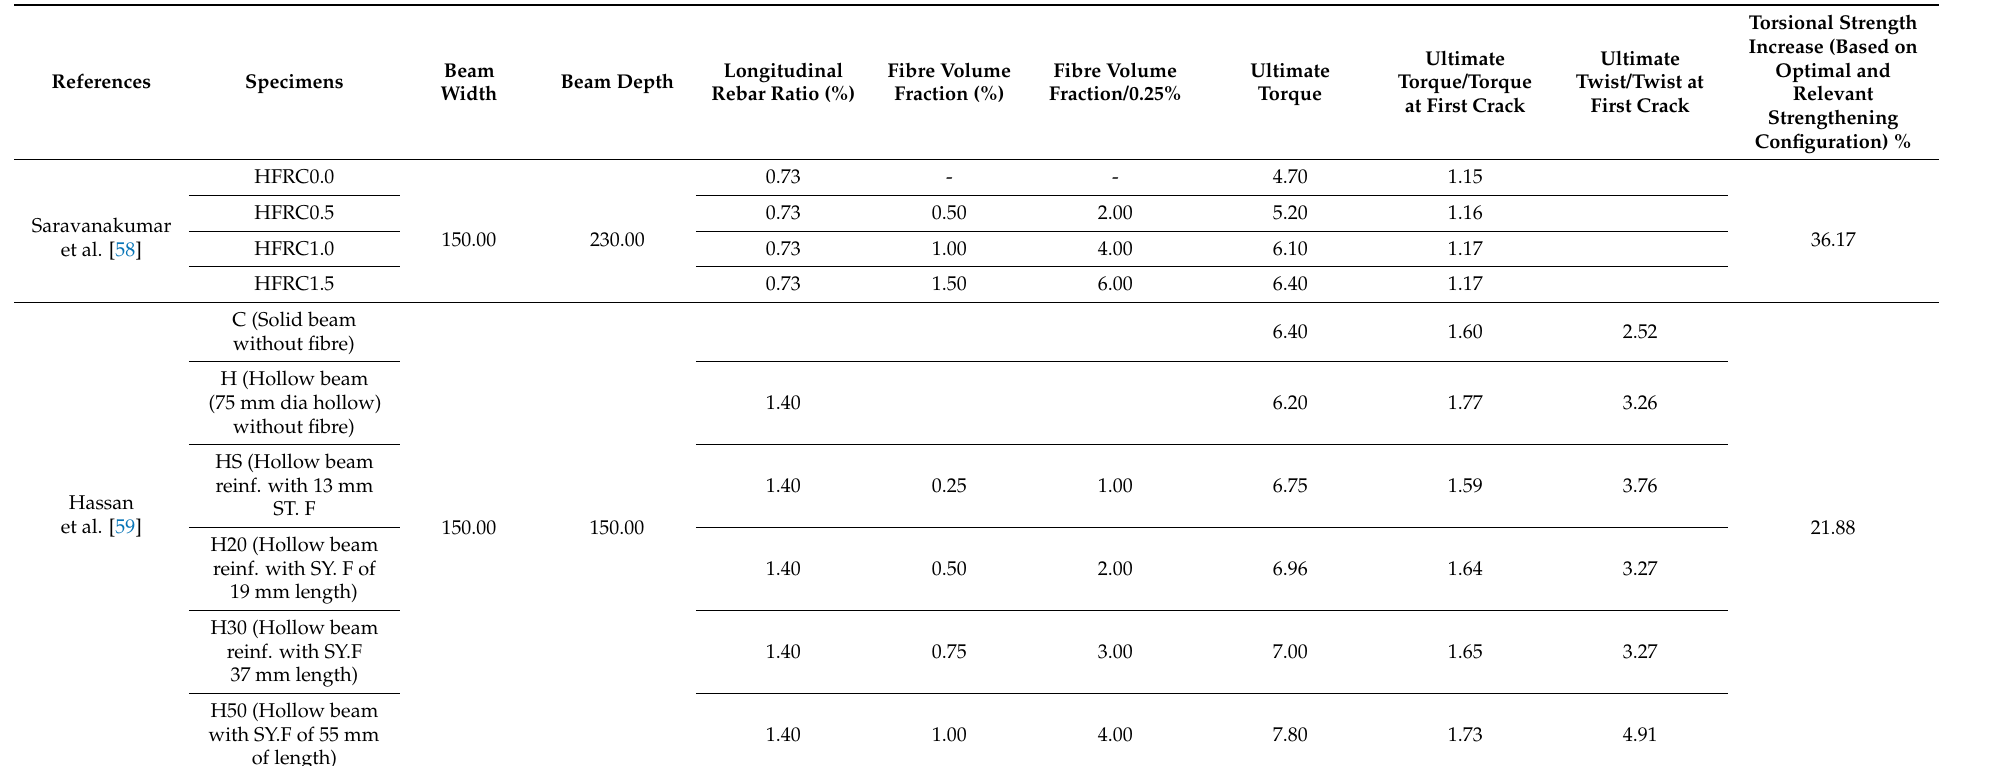
Table 10. Comparison of different experimental studies for hybrid fibre reinforced